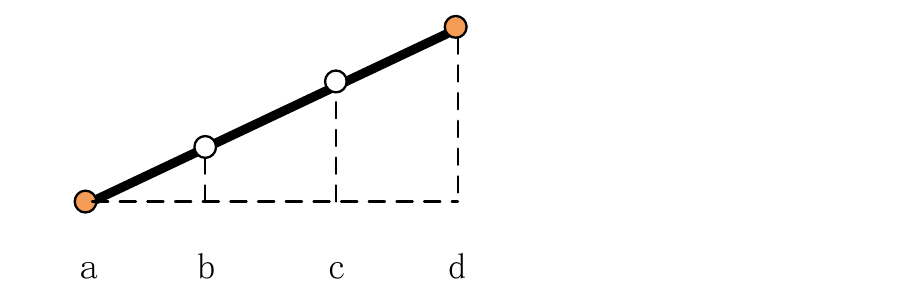
Figure 3. Gap-filling method. Solid time series points represent known time series values, and hollow Figure 3. Gap ‐ filling method. Solid time series points represent known time series val ‐ time series points represent missing time series values. ues, and hollow time series points represent missing time series values.